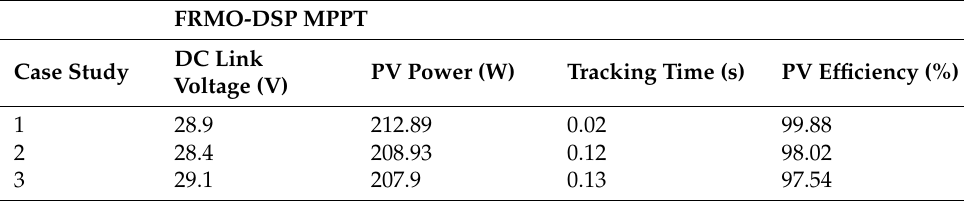
Table 4. Case studies tabulated results for the MPPT algorithm.